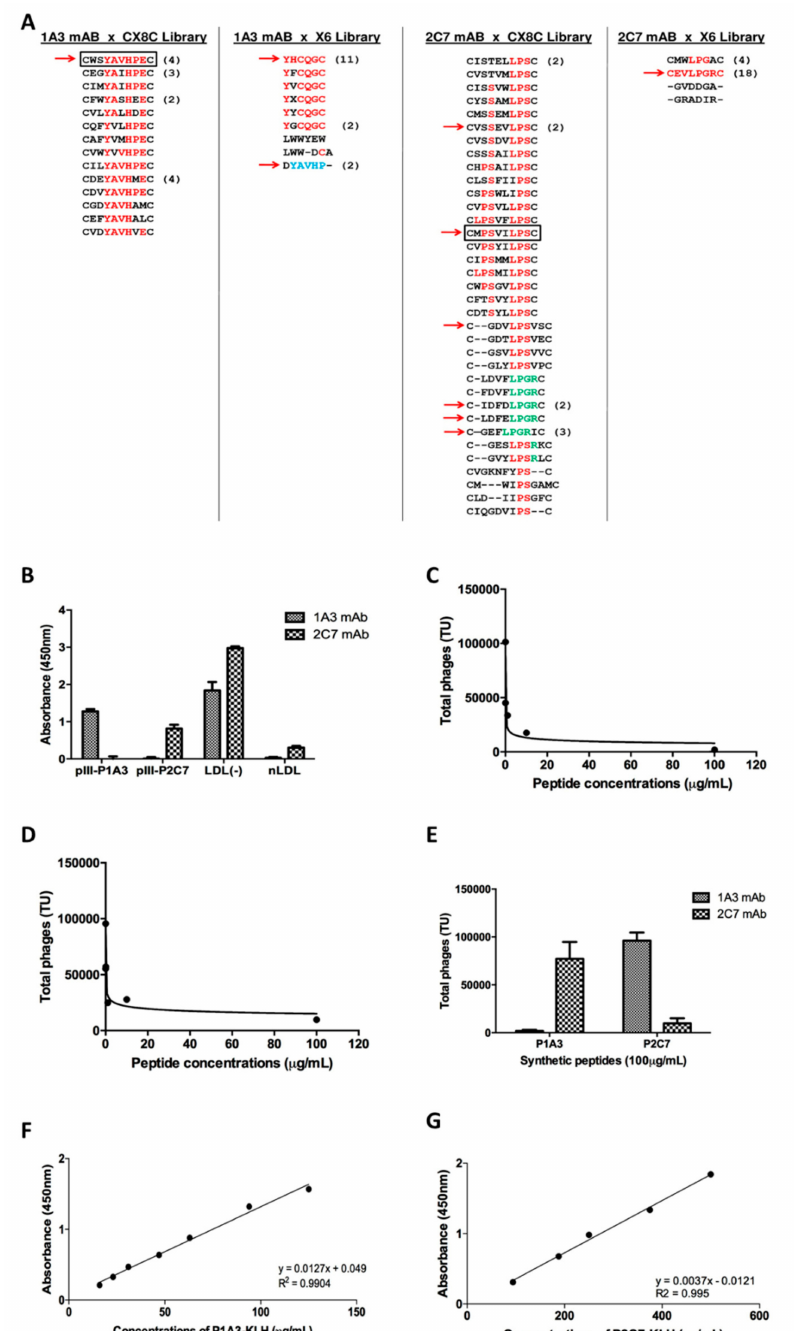
Figure 1. Anti LDL ( − ) monoclonal antibody ligands. ( A ): The peptides identified in each biopanning werealignedusingClustalOmega. Commonaminoacidsarehighlightedinboldandblue. Redindicates hydrophobic residues. All the epitopes were obtained after four rounds of panning, except epitopes from 2C7 mAb with X6 library, which were obtained after three selection rounds. The frequency of identical peptides is indicated in parentheses. The red arrows indicate the peptides that have been chosen to be tested in a binding assay with their respective mABs. Regarding the mAB 1A3, the blue peptides selected from the X6 library have the same amino acid sequence as the peptides selected by the CX8C library. Regarding mAB 2C7, the green peptides selected from the CX8C library have the same amino acid sequence (LPGR) of the peptides selected by the X6 library. The peptides highlighted in a box were used for subsequent assays. ( B ): The immunoassay demonstrated the a ffi nity of 1A3 mAb